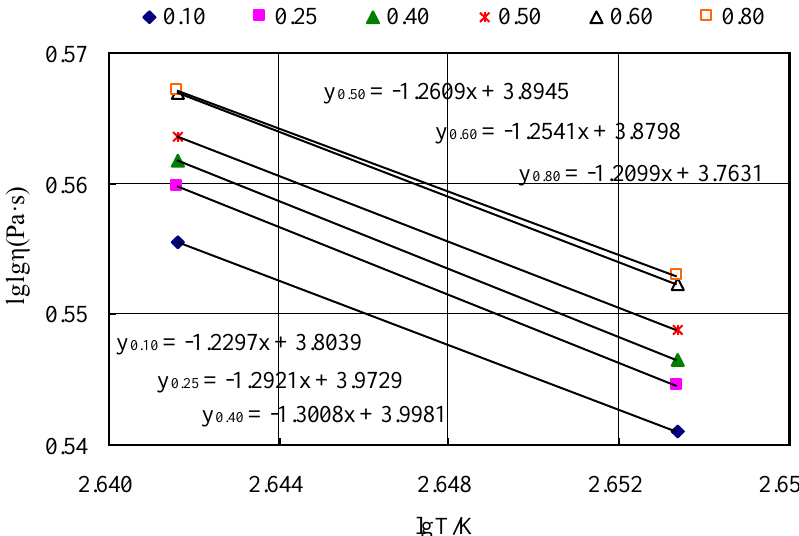
Figure 3. Viscosity–temperature curves of the CRMB mastic. Figure 3. Viscosity – temperature curves of the CRMB mastic.